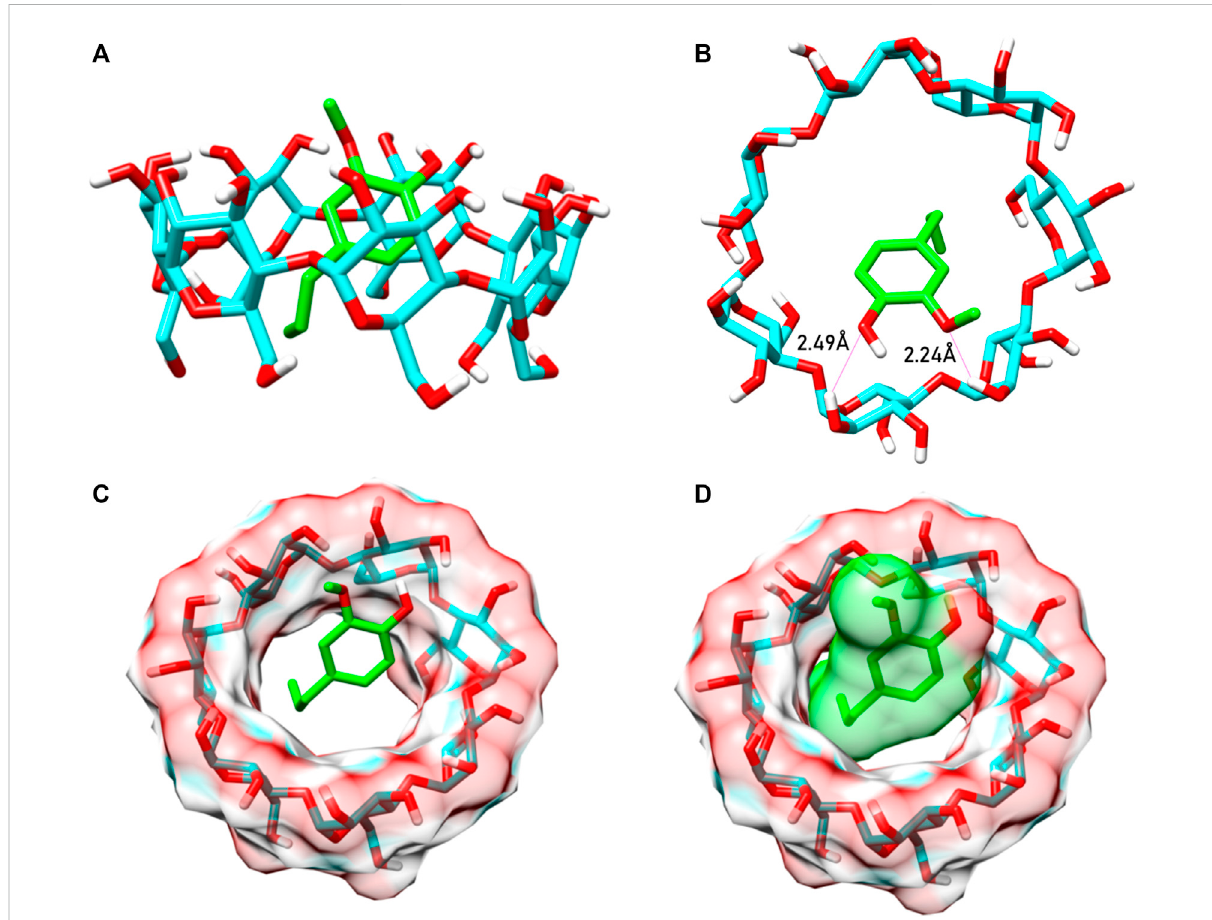
FIGURE 5 Inclusion complex formed between the eugenol (green) and the β -cyclodextrin (cyan). (A) 3D structure of BCD with eugenol forming the complex. (B) Exertinghydrogenbondswiththemain electronegative groupstructureof EG. (C) EG (ingreen)inside the BCDcavity. (D) Eugenol with VDW surface, demonstrating binding in the BCD cavity.